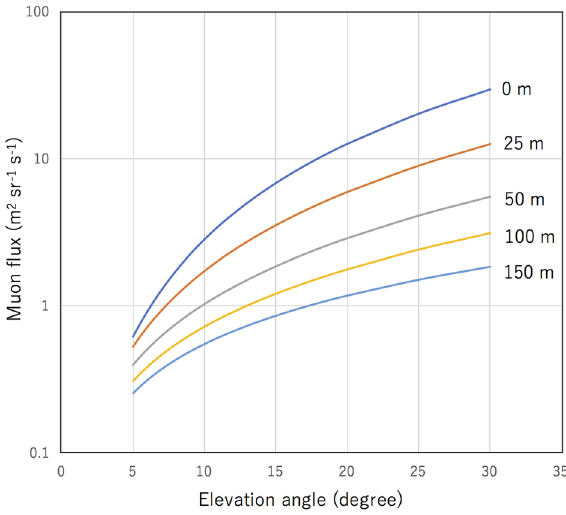
Figure 3. Integrated muon flux as a function of the elevation angle for different distances: 0 m (blue), 25 m (red), 50 m (gray), 100 m (yellow), and 150 m (light blue) between the MSM and the shoreline.